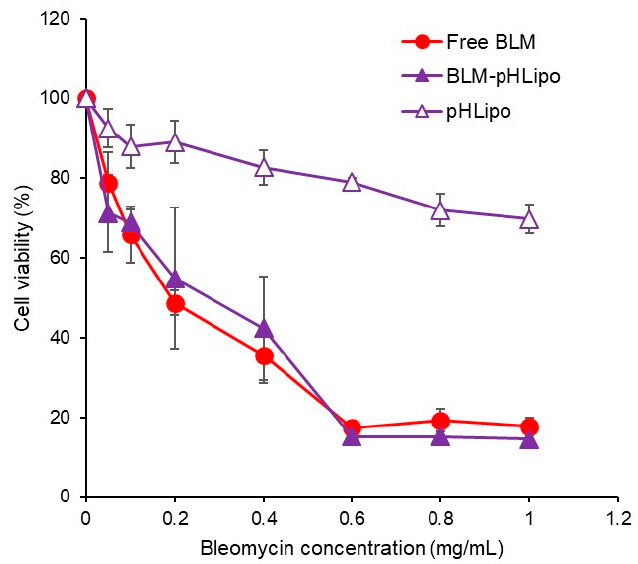
Figure 5. Effect of BLM-loaded pH-sensitive liposomes on cell viability. Colon-26 cells were treated with free BLM, pHLipo, or BLM-pHLipo at varying BLM concentrations for 24 h. The cell viability was evaluated. Each plot shows the mean ± SD ( n = 3).